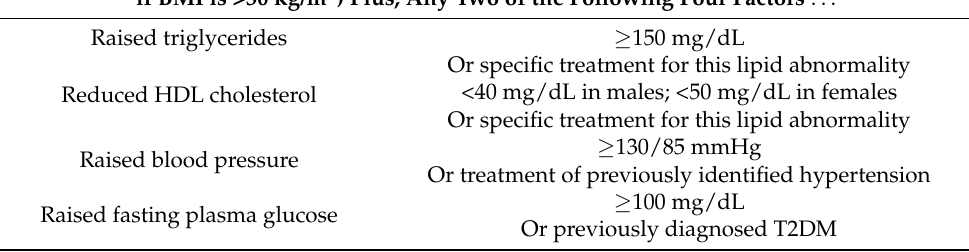
Table 1. Metabolic syndrome as defined by the IDF criteria. Criteria: Central Obesity (Defined as Waist Circumference ≥ 90 cm for South and East Asian Men and ≥ 80 cm for South and East Asian Women, with Ethnicity-Specific Values, Assumed if BMI is >30 kg/m 2 ) Plus, Any Two of the Following Four Factors . . . Raised triglycerides ≥ 150 mg/dL Or specific treatment for this lipid abnormality <40 mg/dL in males; <50 mg/dL in females Reduced HDL cholesterol Or specific treatment for this lipid abnormality ≥ 130/85 mmHg Raised blood pressure Or treatment of previously identified hypertension ≥ 100 mg/dL Raised fasting plasma glucose Or previously diagnosed